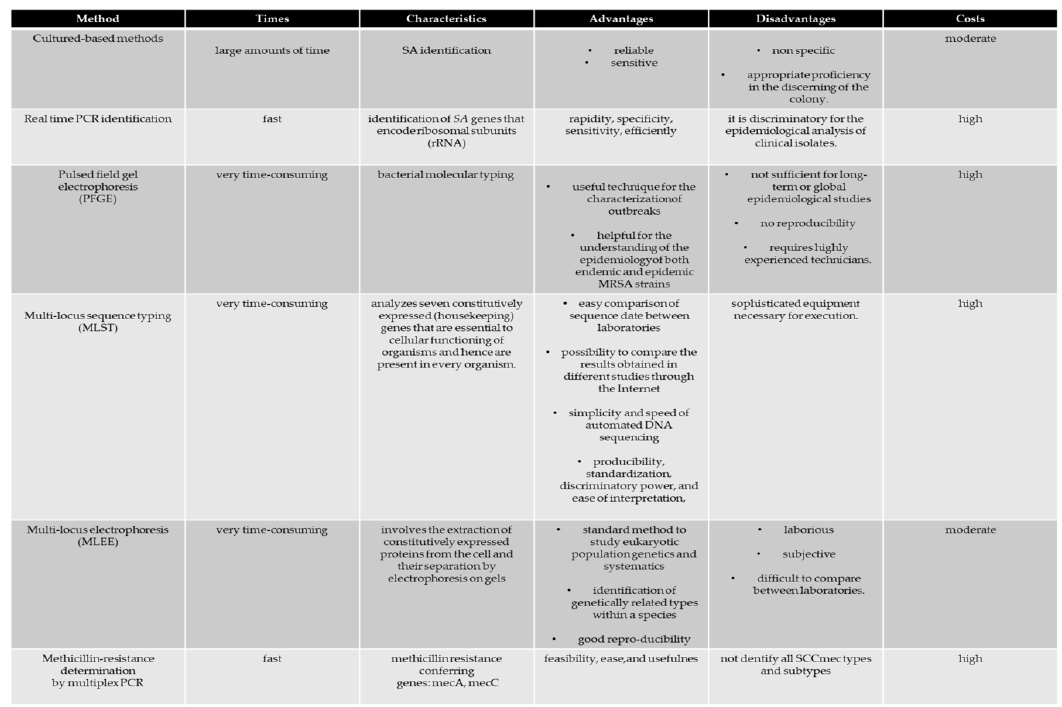
Figure 6. Common laboratory methods for the diagnosis of Staphylococcus aureus .